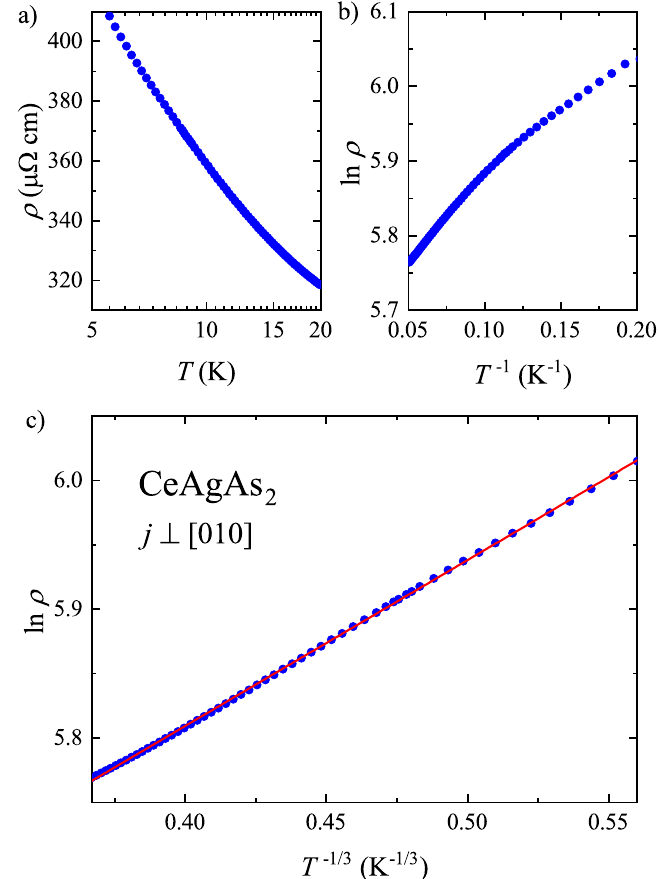
Figure 7. Different scaling relations of the resistivity data of CeAgAs 2 , measured in the range 5.5–20 K as described in the caption of Figure 6, appropriate for ( a ) incoherent Kondo scattering, ( b ) semiconducting activation of charge carriers across energy gap, ( c ) variable range hopping of electrons between localized in-gap states. Solid line represents the function ρ ( T ) = ρ H exp [( T H / T ) x ] with x =